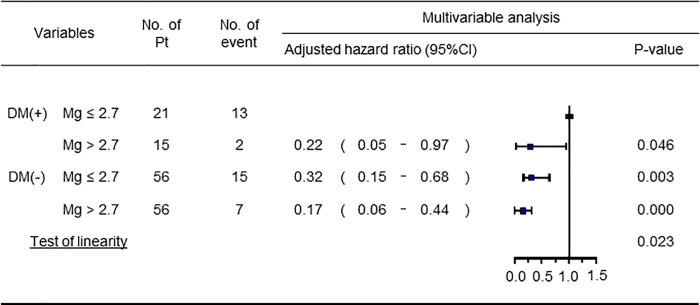
The multivariable Cox proportional hazards model.Adjusted hazard ratios were obtained by the multivariable model using the imbalanced covariates: age, duration of hemodialysis, systolic blood pressure, serum albumin levels, C-reactive protein, and normalized protein catabolic rate.